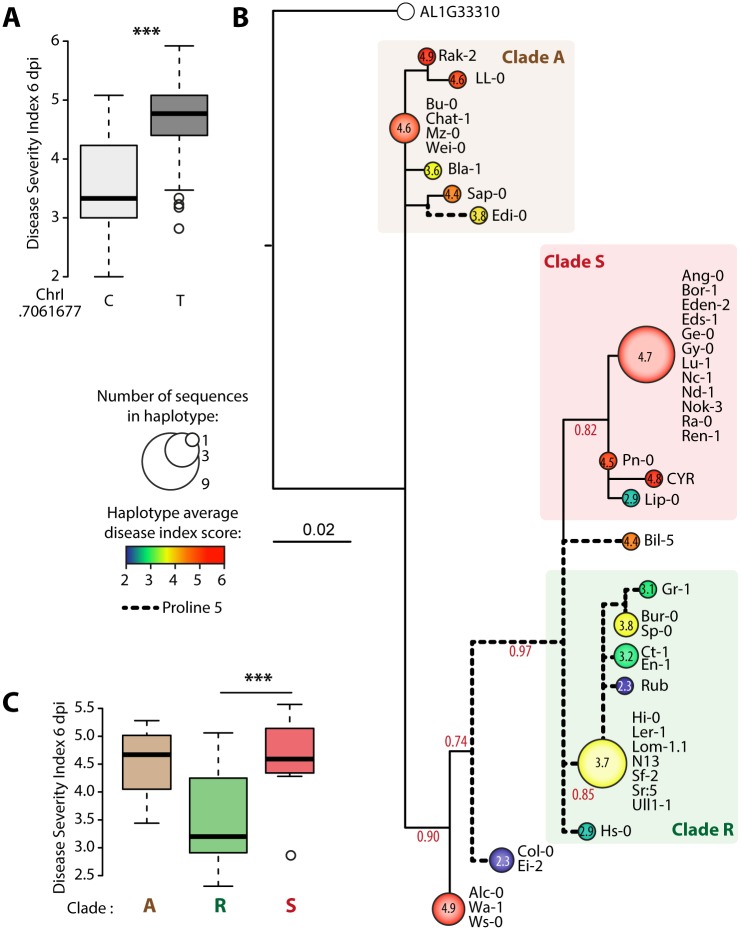
Natural diversity at POQR locus in A. thaliana associates sequence and expression polymorphism with QDR.(A) Distribution of disease severity index for accessions harboring either a C or a T at position 7061677 of chromosome 1, corresponding respectively to a proline or serine at POQR amino acid position 5 (*** Student’s t test p-value<0.01). (B) Maximum likelihood phylogenetic tree of POQR protein sequences in 46 A. thaliana accessions. Identical sequences were collapsed; nodes are sized proportionally to the number of accessions with identical POQR isoform, and colored according to the average disease severity index after S. sclerotiorum inoculation, indicated at the center of each node. Nodes are labeled with accessions forming the corresponding group. Portions of the network corresponding to clades A, S and R are highlighted with colored background. Branches carrying POQR isoforms with a proline at position 5 are shown as bold dotted lines. Support corresponding to an SH-like approximate likelihood-ratio test is shown for major branches. (C) Distribution of disease severity index 6 days after S. sclerotiorum inoculation in major POQR clades (*** Student’s t test p-value<0.01).